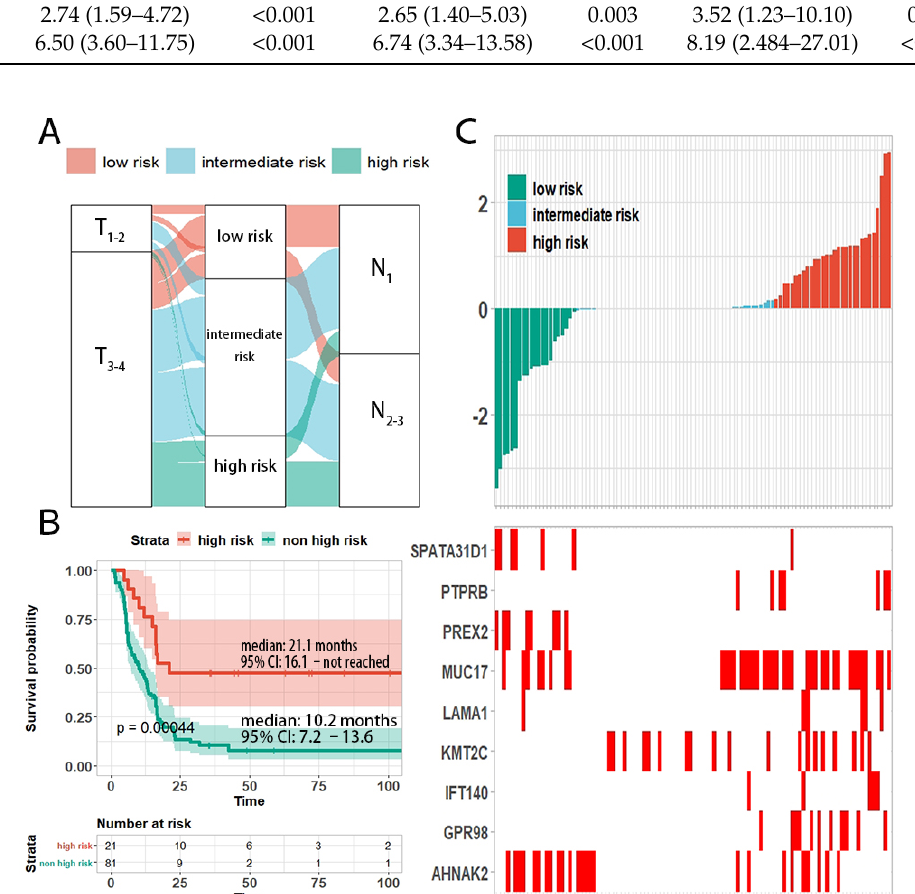
Figure 4. Risk stratification of patients with N 2–3 staging. ( A ) Sankey plot displaying the relationship between the risk scores of patients and different pathological stages. ( B ) Survival curves showing that patients with N 2–3 but low genetic risks had a relatively longer DFS time. ( C ) Heatmap showing the mutation profile of N 2–3 ESCC patients in different recurrence risk. PREX2 and SPATA31D1 mutations were enriched in N 2–3 low-risk